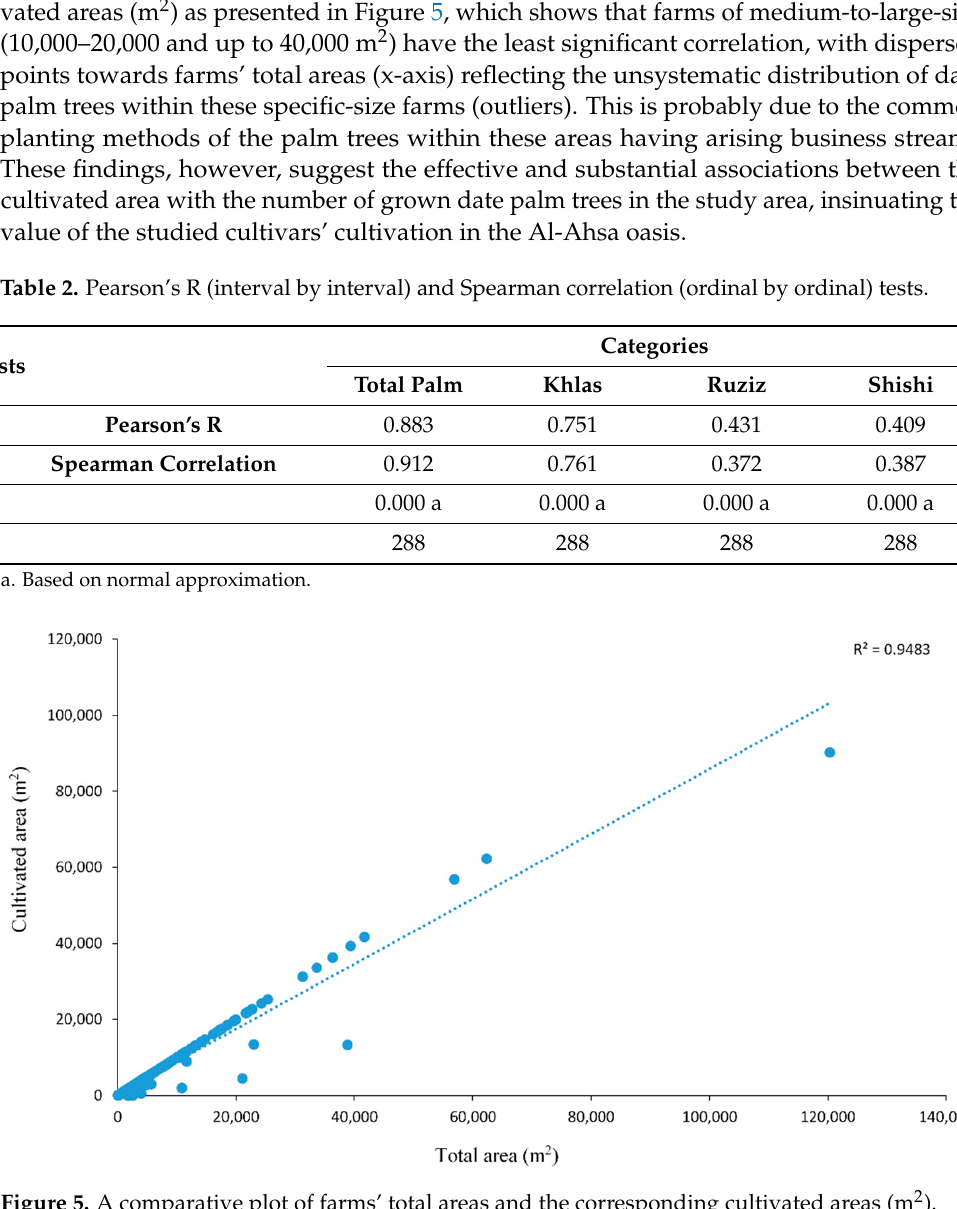
Figure 5. A comparative plot of farms’ total areas and the corresponding cultivated areas (m 2 ).